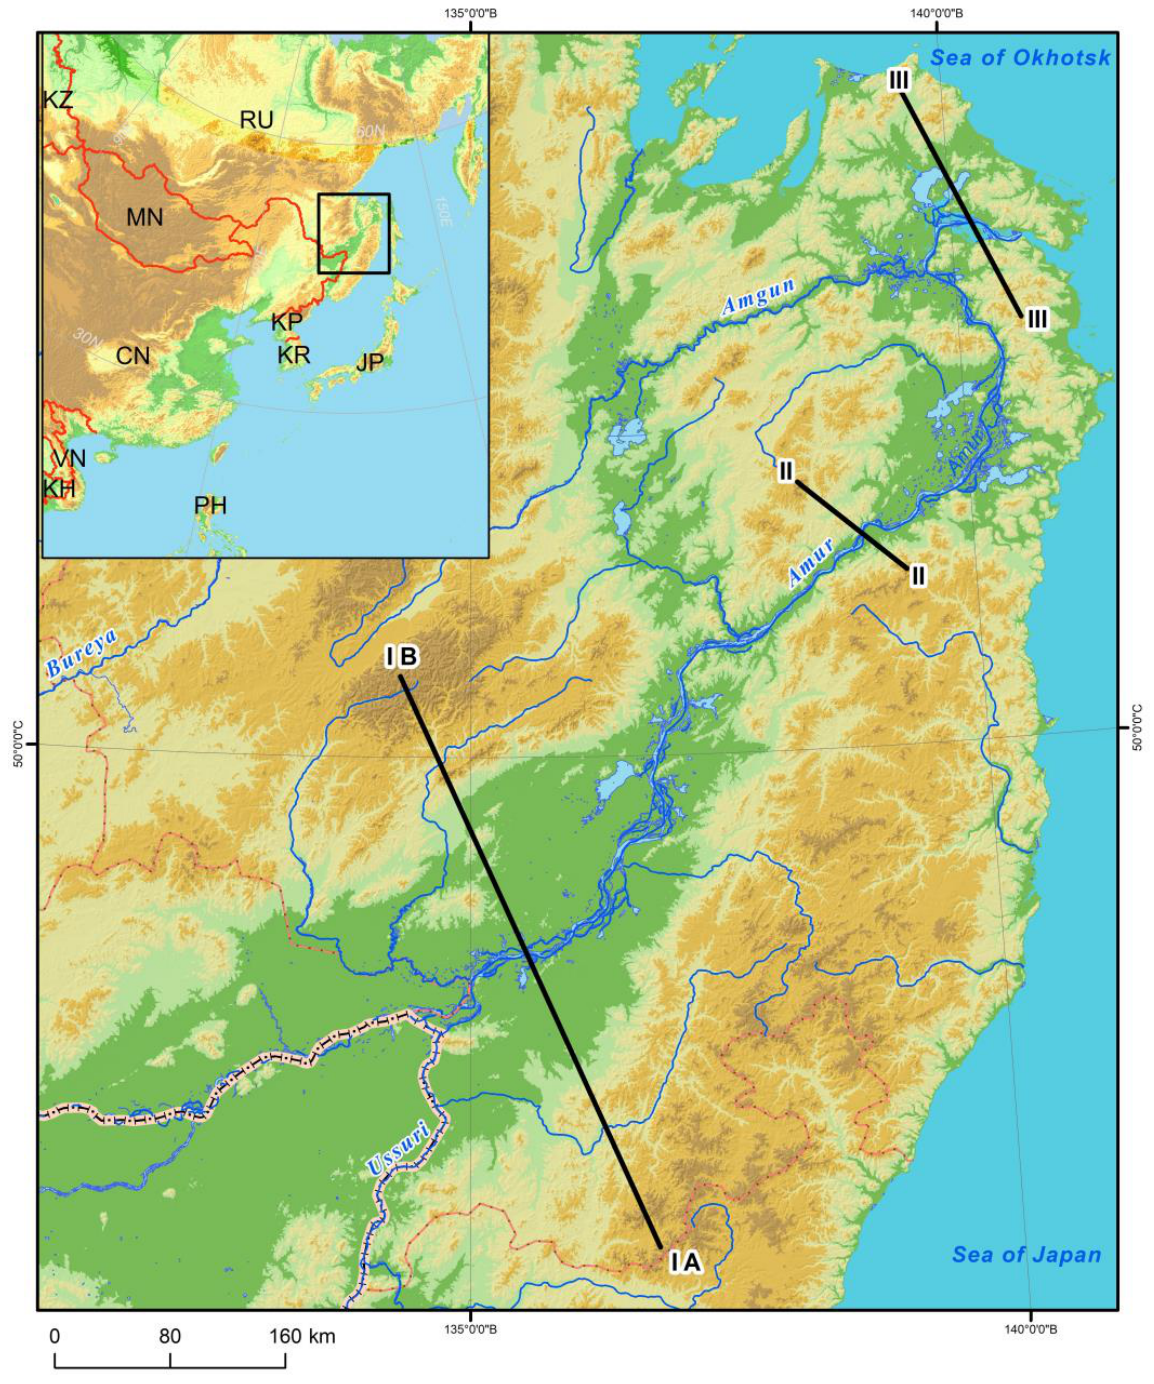
Figure 9. Map showing the position of hypsometric profiles within the Lower Amur region.